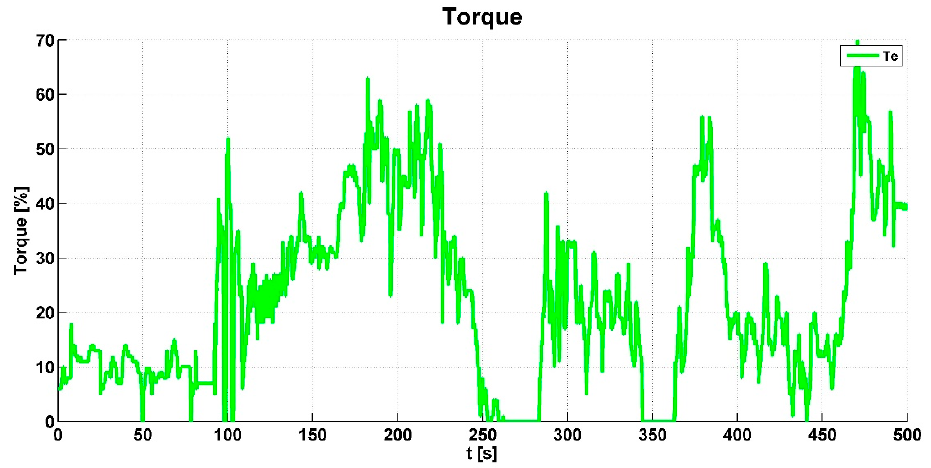
Figure 12. Engine torque value.